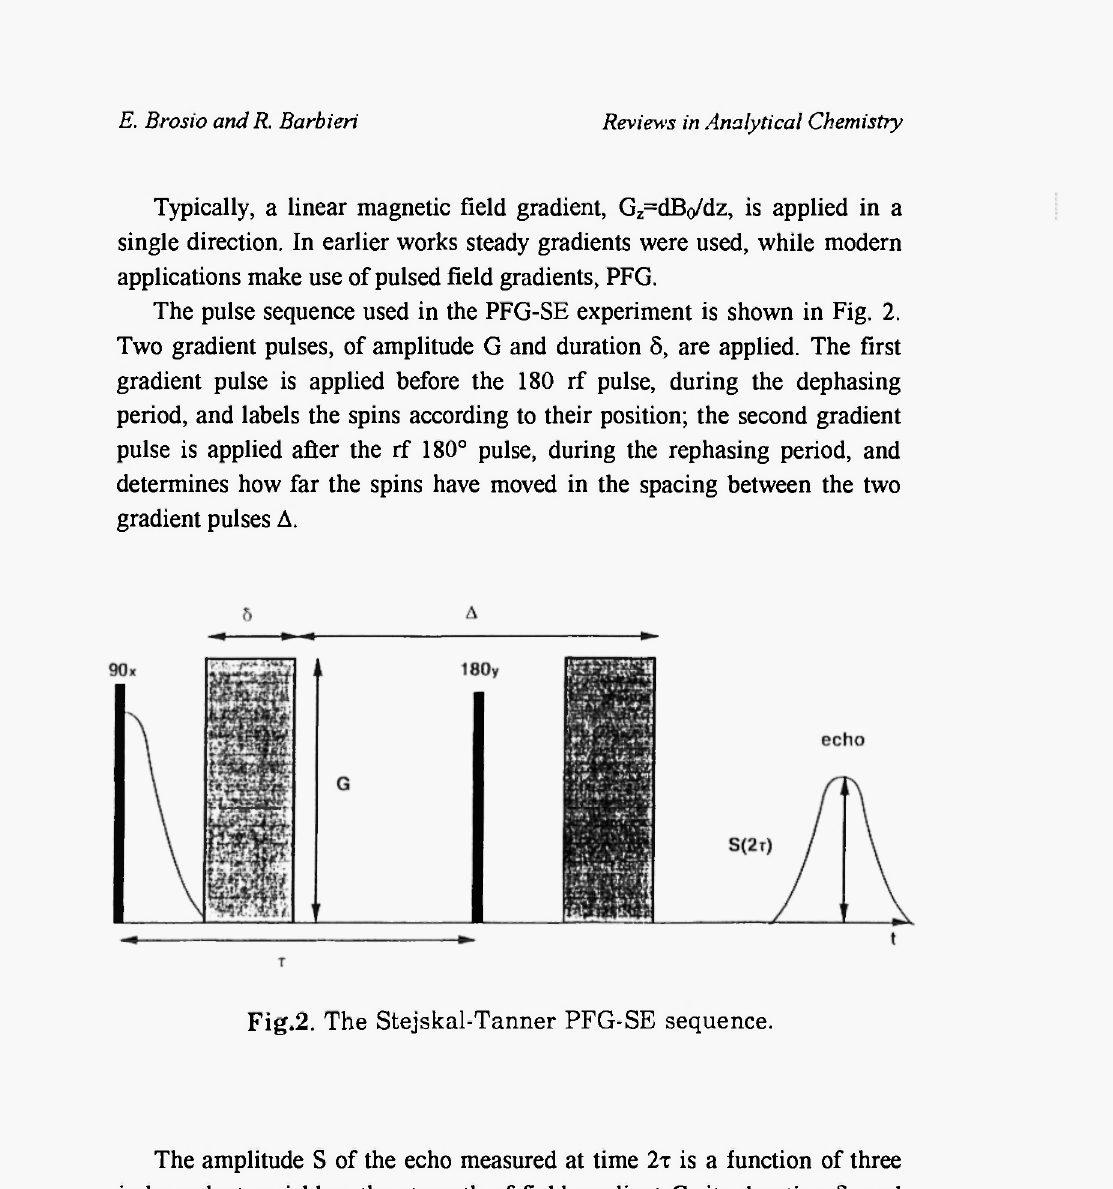
Fig.2. The Stejskal-Tanner PFG-SE